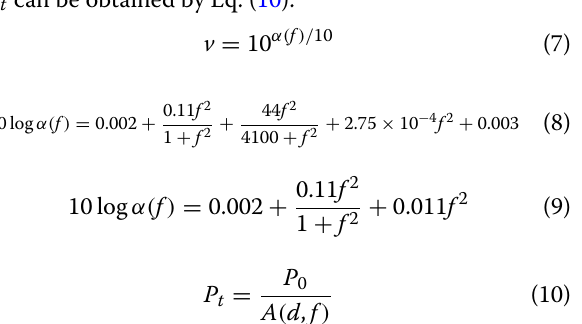
3 Improved energy-balanced routing